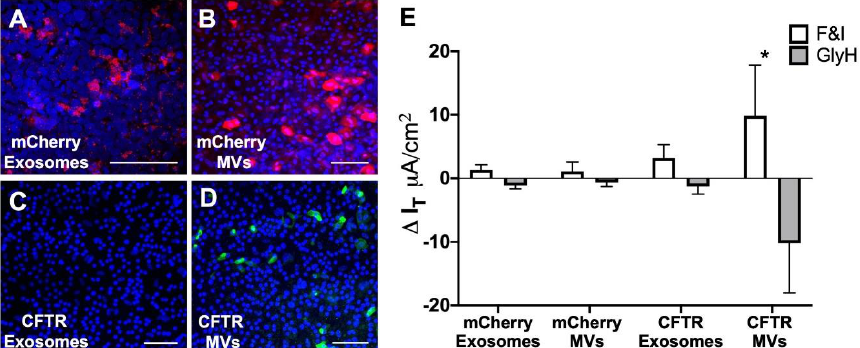
Figure 5. MV-mediated correction of chloride (Cl − ) transport in cystic fibrosis (CF) human primary epithelia. HAE CF were treated apically with A549-derived EVs: ( A ) mCherry exosomes, ( B ) mCherry MVs, ( C ) CFTR exosomes, or ( D ) CFTR MVs for 4 h. HAE CF were pretreated with 0.1% LPC for 2 h before EVs treatment. After 24 h, HAE CF were fixed, permeabilized, and examined using confocal microscopy for mCherry (red) or immunostained for CFTR protein (green). Nuclei were stained with DAPI (blue). Scale bar = 100 µ m. ( E ) Transepithelial Cl − current was measured in HAE CF treated with